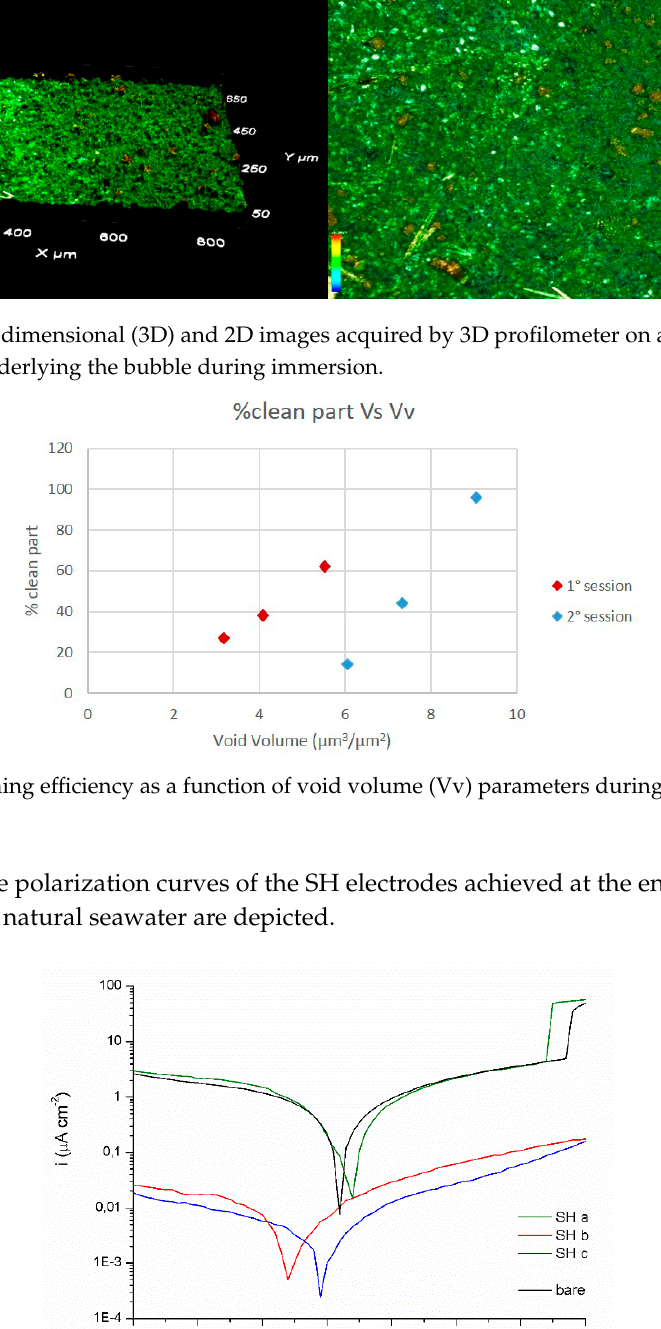
Figure 12. Polarization curves of aluminium electrodes covered with superhydrophobic coating after two months exposition in natural seawater. The samples were exposed, turning the SH surface to face the bottom of the